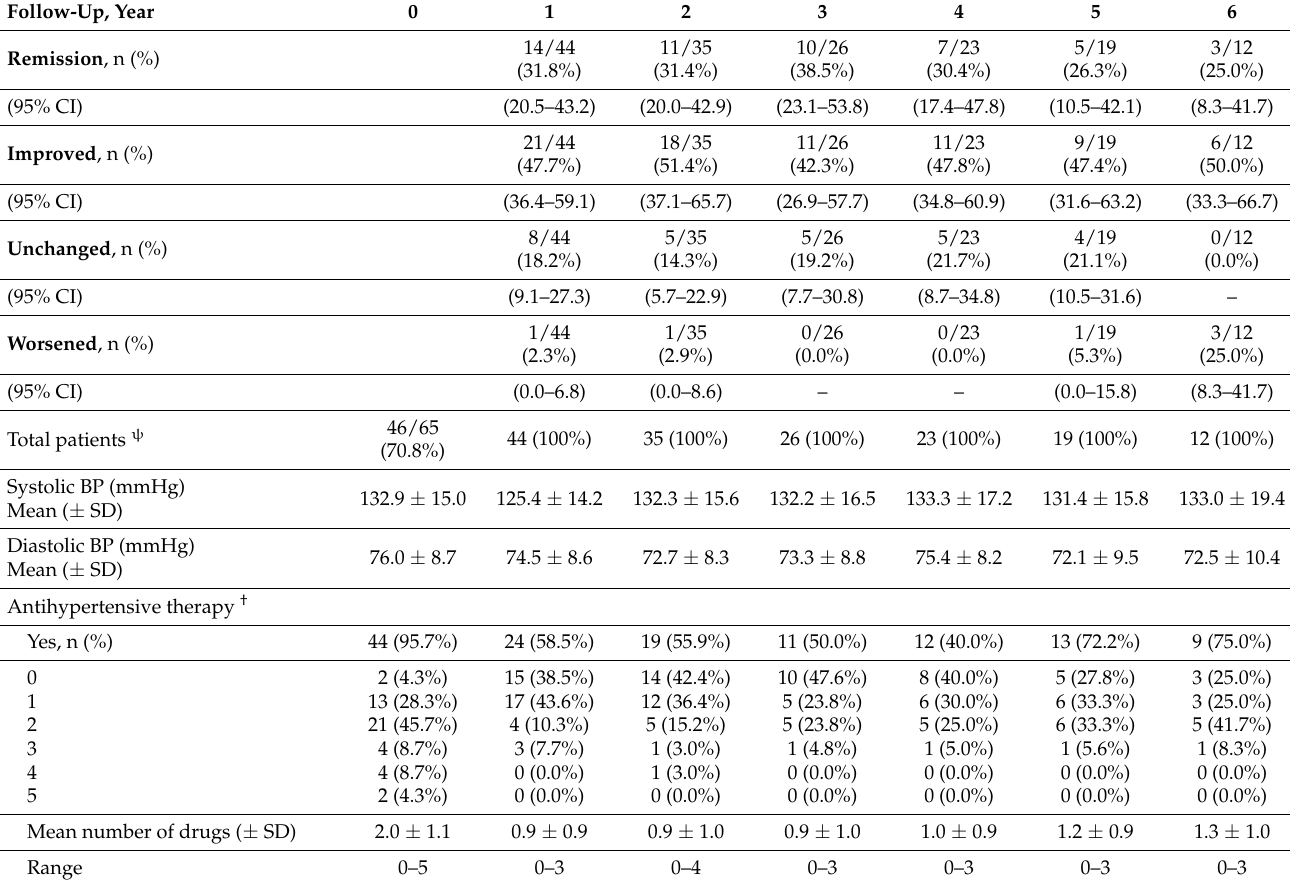
Table 5. Yearly remission, improved, persisting and worsened rates of hypertension following bariatric surgery b